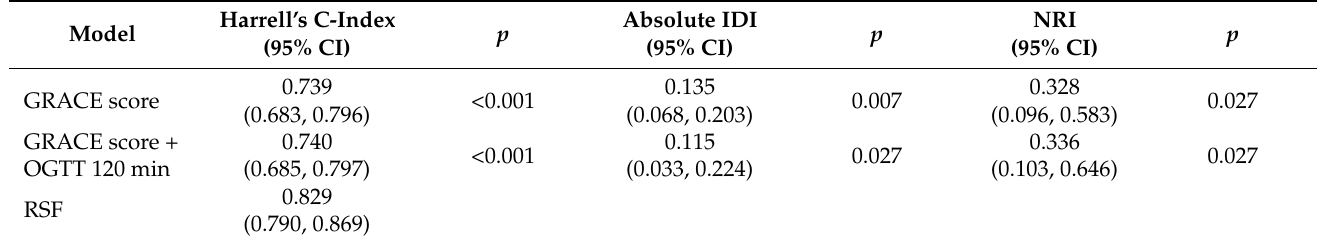
Table 4. GRACE-score-based models compared to the best-performing